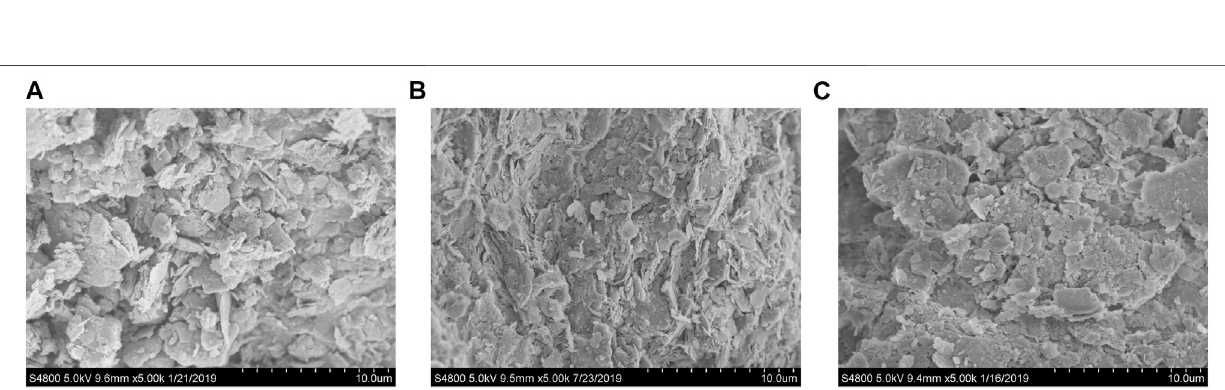
FIGURE 9 | SEM images of solidi fi ed muddy soil at different curing ages (A) 7 days (B) 28 days (C) 90 days